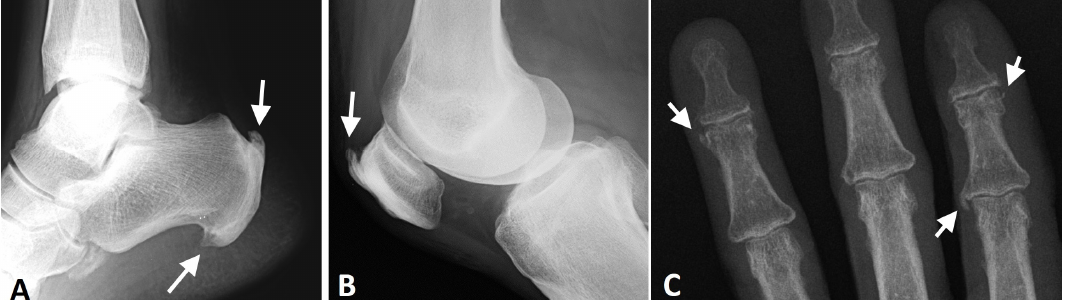
Figure 9. Radiographs of the ankle, knee, and hand of a patient with thoracic DISH (not shown). ( A ) Lateral radiograph of the ankle, showing coarse, thick enthesophytes in the attachment of the Achilles tendon and plantar fascia to the calcaneus (arrows). ( B ) Lateral knee radiograph showing thick, coarse enthesophytes (arrow) in the attachment of the quadriceps tendon to the patella. ( C ) AP radiograph of the fingers, showing enthesophytes in the medial side of the 2nd metacarpophalangeal joint and 4th distal interphalangeal joint and the lateral side of the 2nd distal interphalangeal joint (arrows).